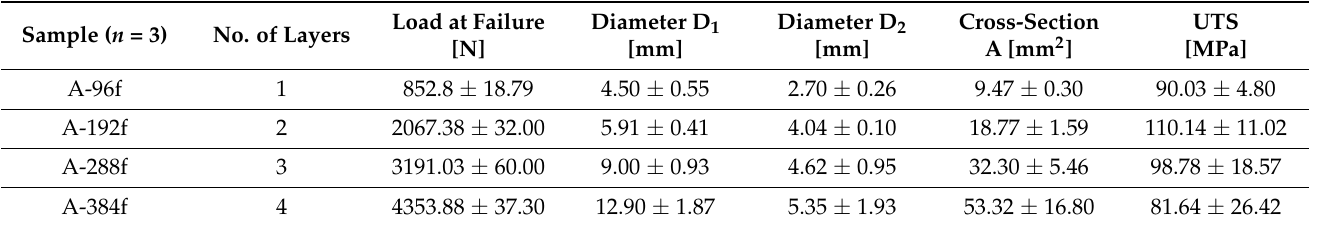
Table 4. Mechanical upscaling. Summary of the mechanical characteristic for varying numbers of filaments